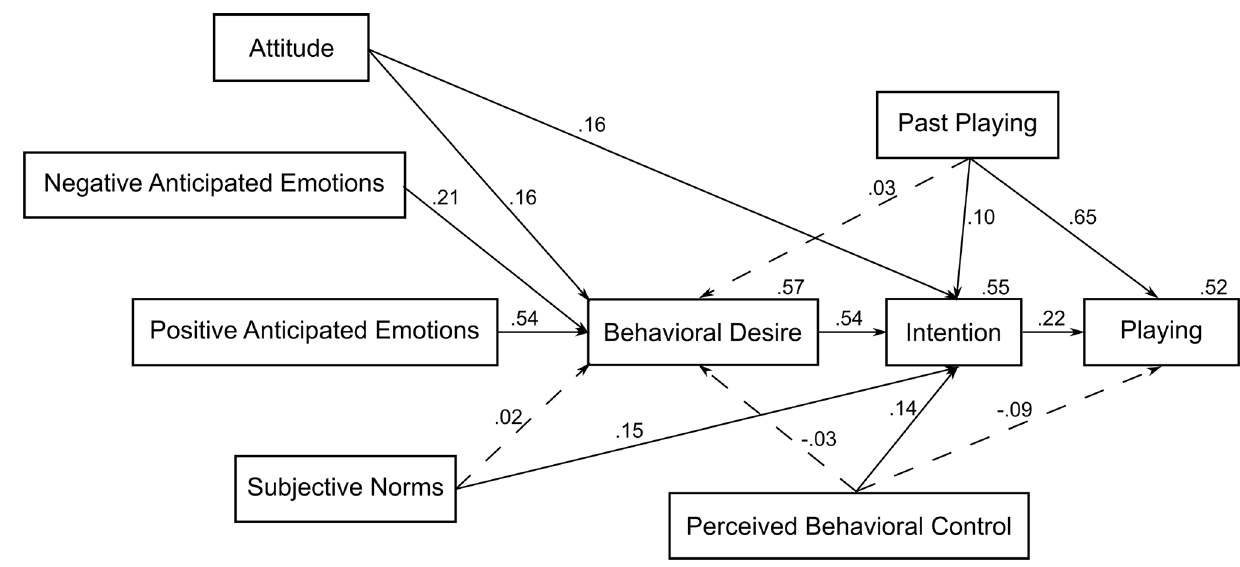
Figure 2. Parameters estimates for the MGB applied to video game playing ( N =